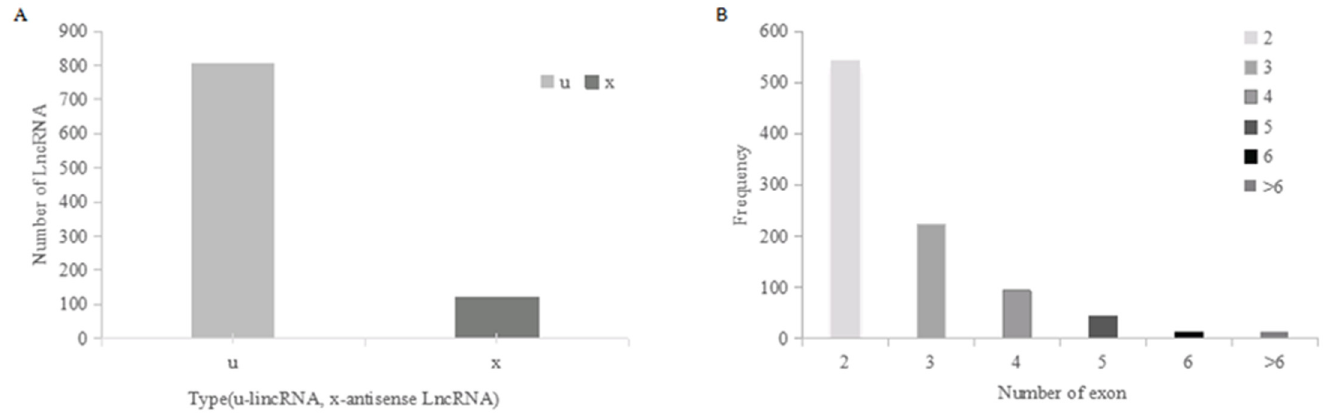
PLOS ONE | DOI:10.1371/journal.pone.0156128 June 21,